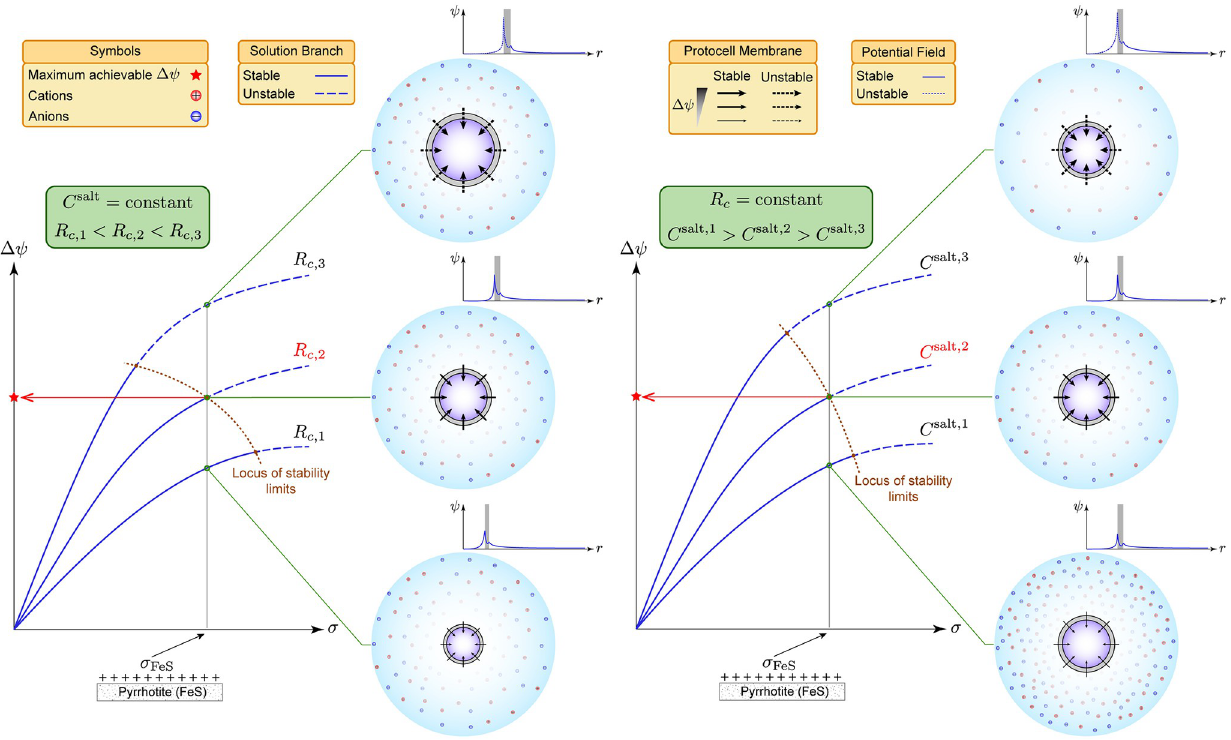
Fig 3. Trade-off between stability and the sensitivity of the membrane potential Δ ψ to surface-charge density σ . Solution branches for a given tortuosity coefficient ϑ are qualitatively plotted for several R at fixed C salt (left diagram) and several C salt at fixed R (right diagram). Quantitative solution branches c c and their stability limits are shown in S3 Fig and S4 Fig, respectively. In both cases, there is a critical σ and Δ ψ , beyond which stability is lost. At fixed C salt (left diagram), larger membrane potentials can be achieved for a given σ when R is larger, although stability is lost at a smaller σ . Similarly, at fixed R (right c c diagram), larger membrane potentials can be realized for a given σ when C salt is smaller, but stability is lost at a smaller σ . Consequently, for a given σ corresponding to the constituents of the membrane ( e.g ., FeS), there is an intermediate R at fixed C salt (highlighted in red in the left diagram) or an c intermediate C salt at fixed R c (highlighted in red in the right diagram) that furnishes the maximum achievable Δ ψ . Arrows on the membrane point in the direction, in which Δ ψ exerts force on negative ions.